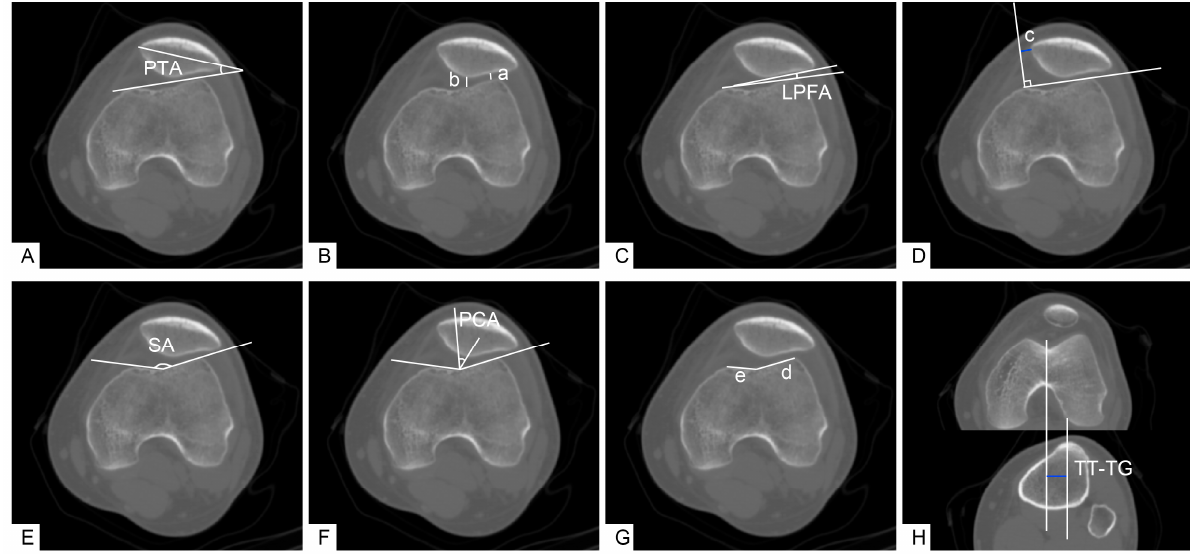
Figure 2. Measurement of assessment indices for patellofemoral instability in knee CT. ( A ) Patellar tilt angle (PTA): the angle between the line connecting each of the highest points of the medial and lateral femoral condyles and the transverse axis of the patella. ( B ) Patellofemoral index (PFI): the ratio of the narrowest width of the medial patellofemoral joint space (b) to the narrowest width of the lateral patellofemoral joint space (a). ( C ) Lateral patellofemoral angle (LPFA): the angle between the tangent line of the lateral articular surface of the patella and a line connecting each of the highest points of the medial and lateral femoral condyles. ( D ) Lateral patellar displacement (LPD): the length between a vertical line connecting each of the highest points of the medial and lateral femoral condyles from the highest point of the medial femoral condyle (c) and the inner edge of the patella. ( E ) Sulcus angle (SA): the angle between the line connecting the lowest point of the femoral trochlear groove and each of the highest points of the medial and lateral trochlear articular surfaces. ( F ) Patellar congruency angle (PCA): the angle between a line connecting the lowest point of the femoral trochlear sulcus and the lowest point of the patellar crest and the bisector of the SA made on the axial image of the patella [14]. ( G ) Sulcus lateral facet ratio (SLFR): the ratio of the lateral articular surface of the femoral trochlear joint (d) to the medial articular surface of the femoral trochlear joint (e). ( H ) Tibial tubercle-trochlear groove distance (TT-TG): the mediolateral distance between the highest point of the tibial tuberosity to the deepest point of the trochlear groove in line with the posterior condylar axis.